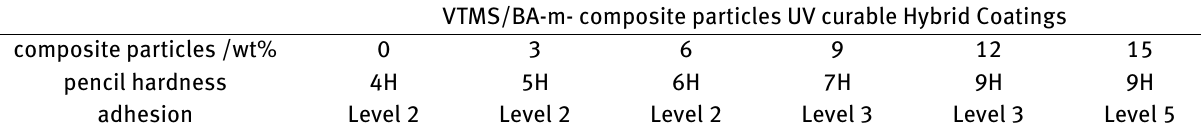
Table 2: The effect of composite particles with different mass fraction on the hardness and adhesion of UV curing coatings VTMS/BA-m- composite particles UV curable Hybrid